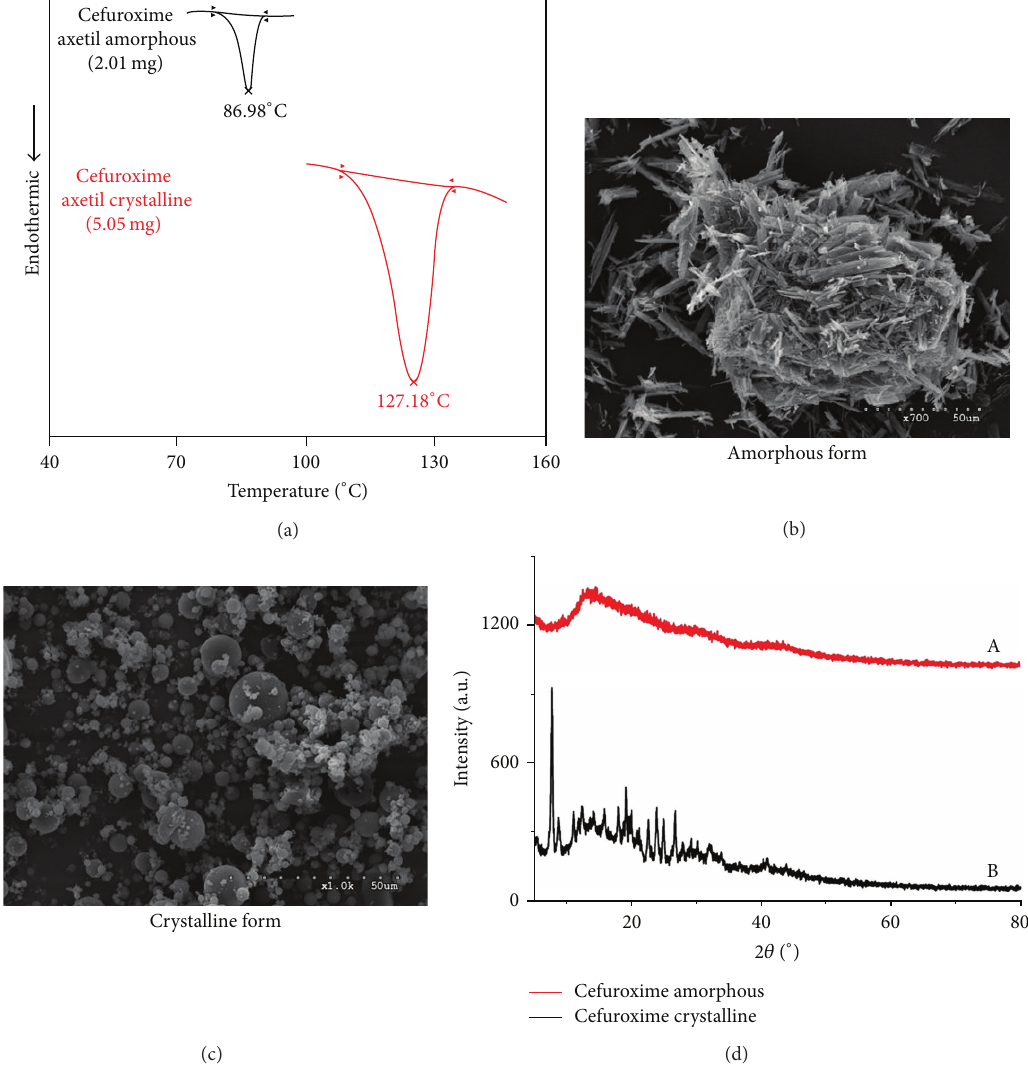
Figure 2: DSC curves (a), SEM images (b, c), and XRPD (d) spectra of amorphous and crystalline forms of cefuroxime axetil.